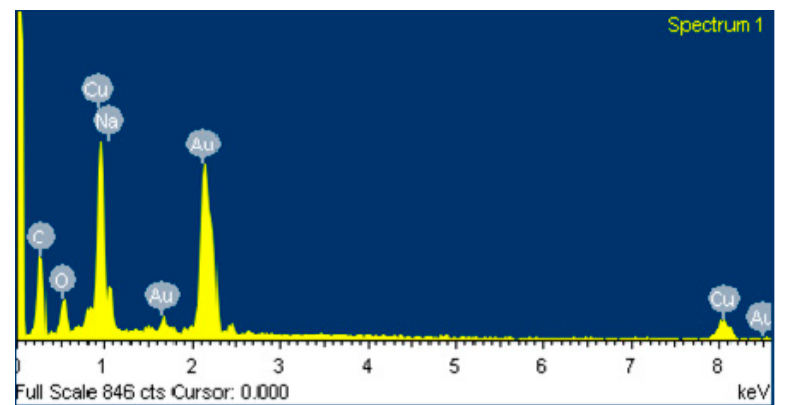
Figure 2. SEM image of gold-loaded multi-walled carbon nanotubes. Arrows pointing to zero valent gold particles.